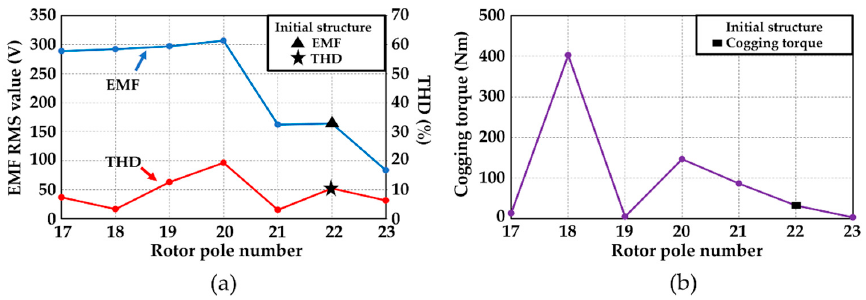
Figure 3. Influence of rotor pole number on the ( a ) EMF profile and ( b ) cogging torque of the V-shaped FSPM generators with a 12-slot stator.